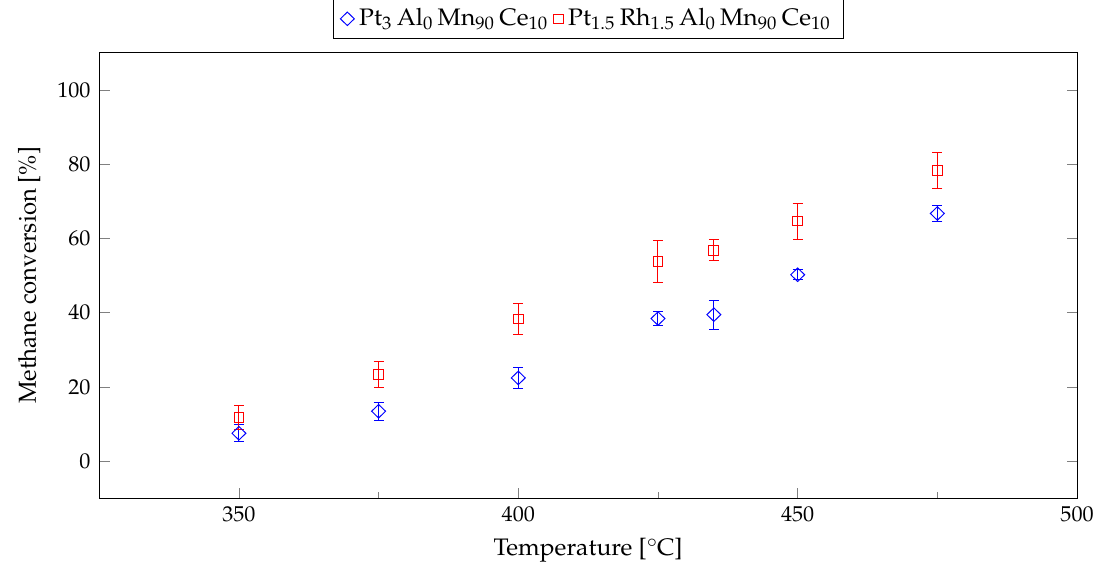
Figure 15. Methane conversion at different temperatures for samples Pt 3 and Pt 1.5 Rh 1.5 Al 0 Mn 90 Ce 10 . 12.5vol.% H 2 O, 12.5vol.% CO 2 , 9.0vol.% O 2 , 0.25vol.% CH 4 , 0.055vol.% CO, 0.012vol.% NO, 0.004vol.% NO 2 , 0.001vol.% SO 2 , balance He, WHSV = 36,000mL/ ( gh ) . Error bars represent standard deviation ( n = 3) as given by Equation 2.